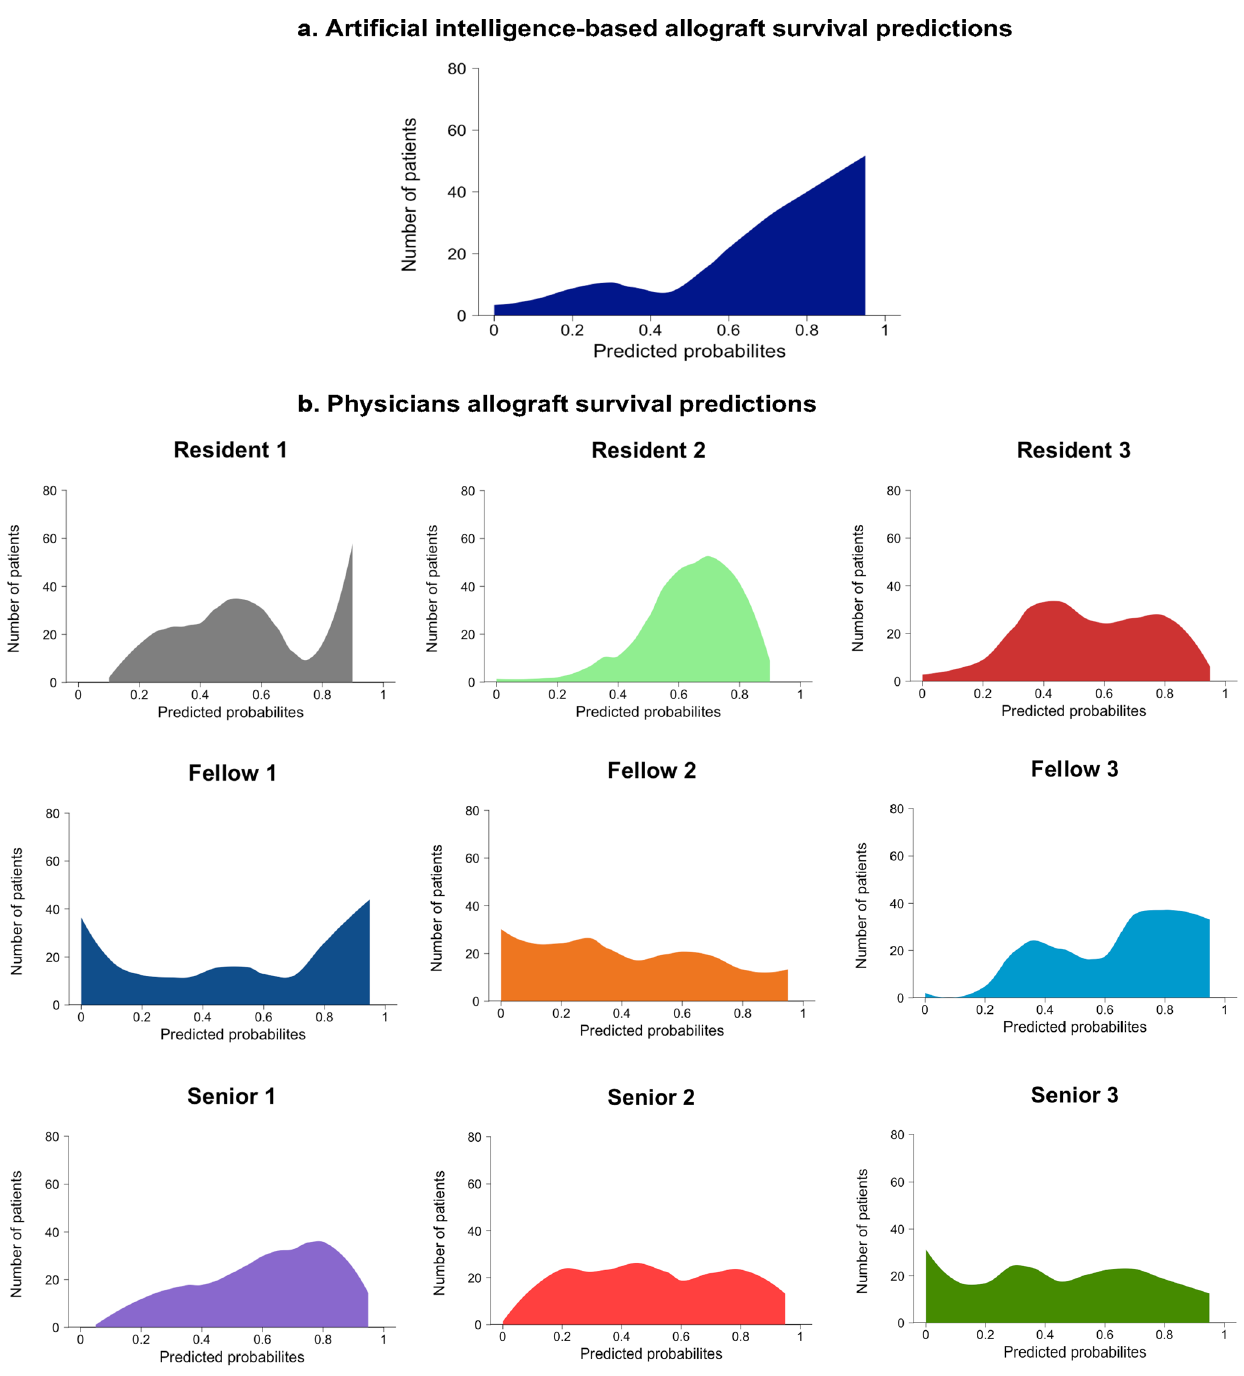
Fig. 2 Distribution of predicted probabilities of allograft survival according: physicians vs arti fi cial intelligence-based prediction system. n = 400 patients, nine transplant physicians and the iBox system. Density plot of the distribution of predicted probabilities. Each color corresponds to one physician or the iBox. The median and the interquartile range of the iBox prediction system ( a ) and each physician ( b ): iBox 78.3% [60.6 – 89.5]; Resident #1,